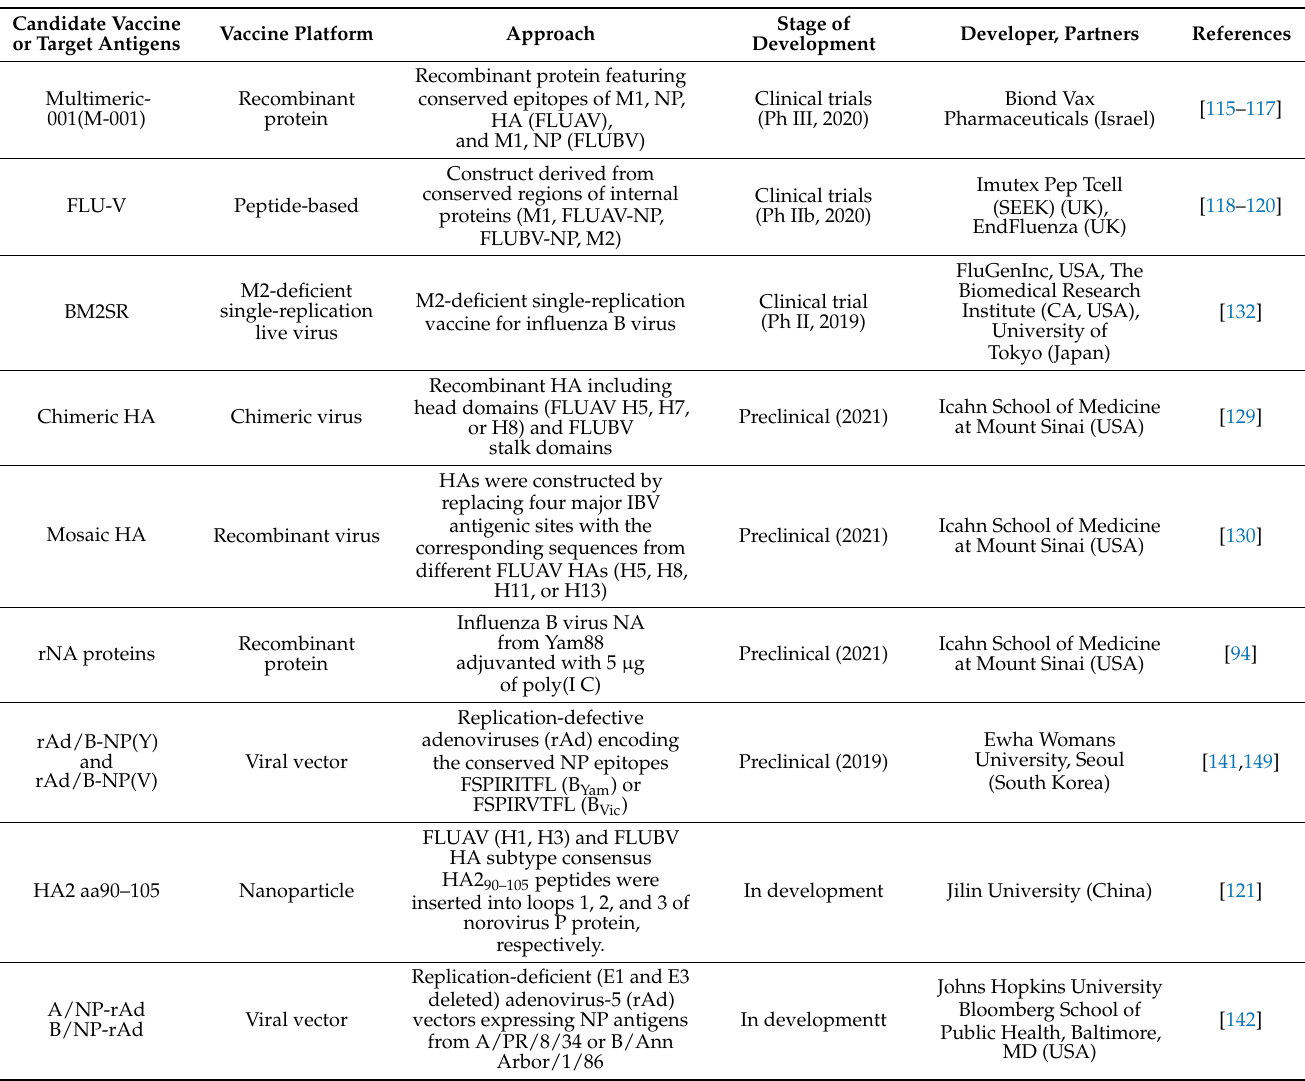
Table 2. Influenza B universal vaccine